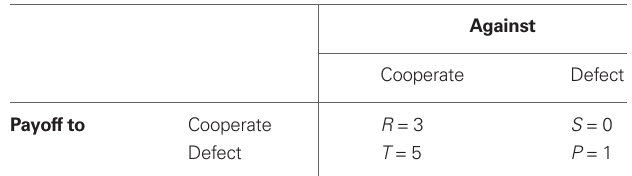
Table 2 | Prisoner’s dilemma matrix.